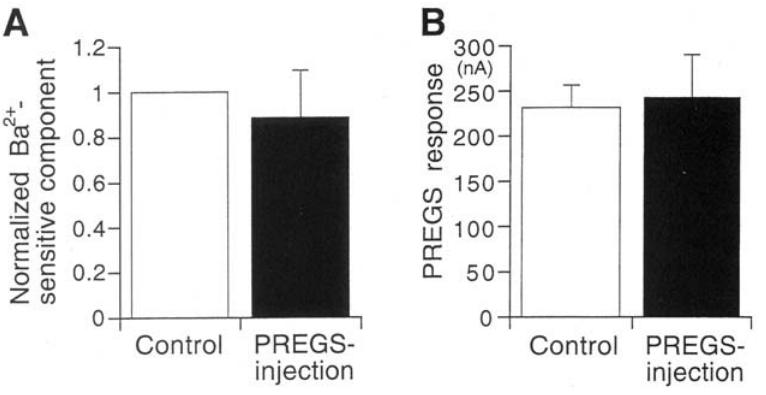
Figure 3. Effect of intracellular PREGS in Xenopus oocytes expressing Kir2.3 channels. (A) Comparison of basal Kir2.3 currents before and after PREGS injection in oocytes expressing Kir2.3 channels. The amplitude of Kir2.3 currents was normalized to the amplitude of 3 mM Ba 2 + -sensitive current components before PREGS injection. (B) Comparison of 50 m M PREGS-induced Kir2.3 currents before and after PREGS injection. Data are expressed as mean 6 SEM.